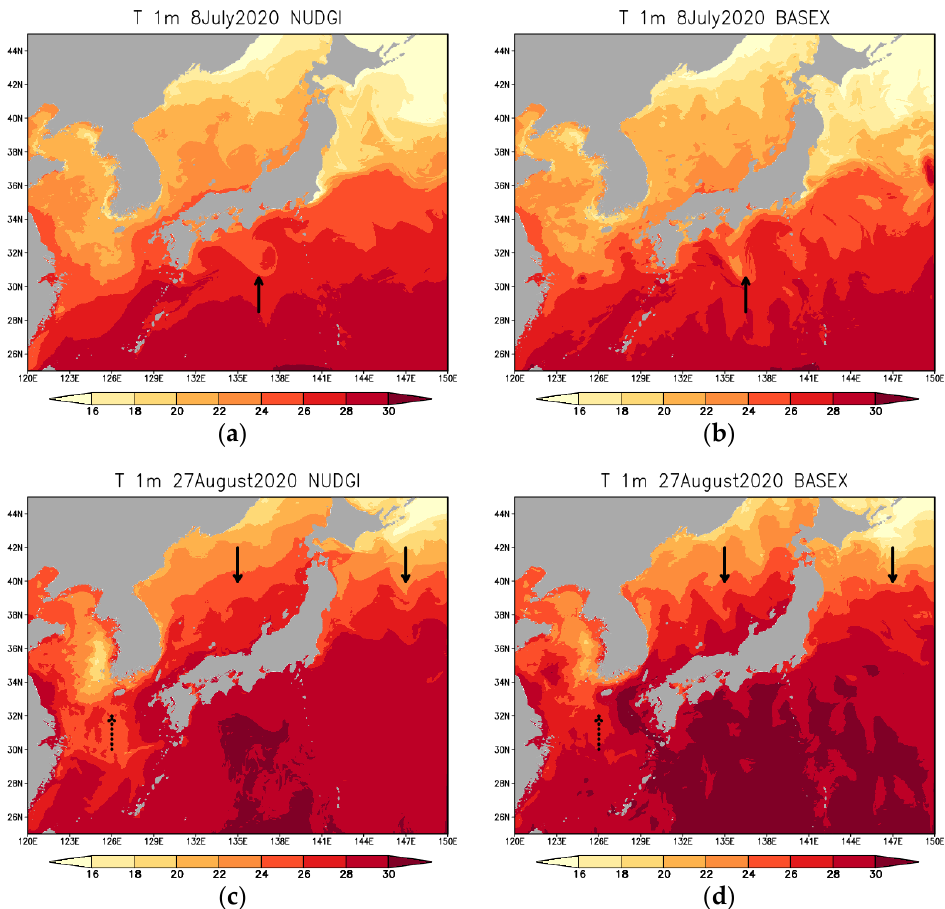
Figure 4. Modeled daily mean SST (in °C). ( a , b ): 8 July 2020. Solid arrows denote the Kuroshio Large Meander south of Japan, ( c , d ): 27 August 2020. Solid (dotted) arrows denote the north–south gradient of SST in the Japan Sea and east of Japan (the typhoon-induced SST reduction). ( a , c ): the NUDGI case, ( b , d ): the BASEX